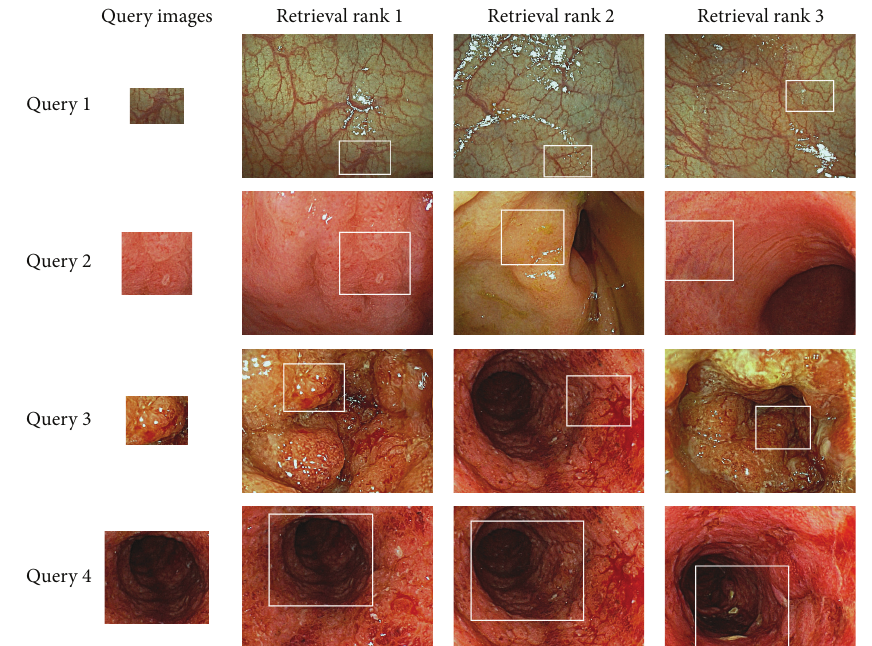
Figure 16: Top three retrieval image rankings for the four query images, which represent different mucosal conditions, from among the 100 target